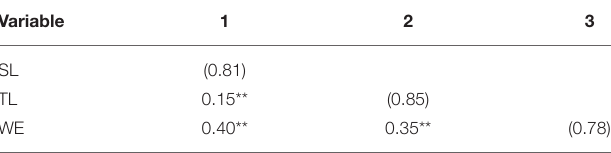
TABLE 4 | Correlation and reliabilities.